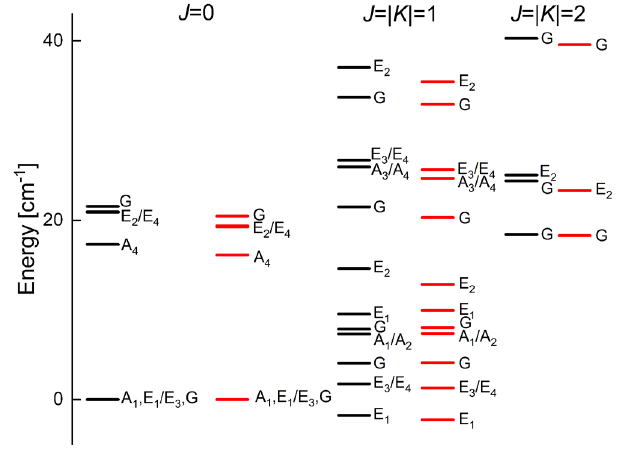
Fig. 4 VRT energy levels of the ammonia dimer. Calculated energy levels (black, in cm − 1 ) of NH 3 – NH 3 . In the rigid-monomer approach used, the permutation-inversion symmetry group is G 36 . This group has four one- dimensional irreducible representations (irreps) A i with i = 1, … , 4, four two- dimensional irreps E i , i = 1, … , 4, and one four-dimensional irrep G 18,25 . The irreps A i correspond to the monomer combination ortho NH 3 - ortho NH 3 , irreps E i to the para NH 3 - para NH 3 combination, and irrep G to the ortho NH 3 - para NH 3 combination, and vice-versa. The energy levels, given relative to the J = 0 ground-state levels of A 1 , E 1 , and G symmetry, are compared with the experimental levels (red) from high-resolution spectra 10,11 . The numerical values are given in Supplementary Table 2.